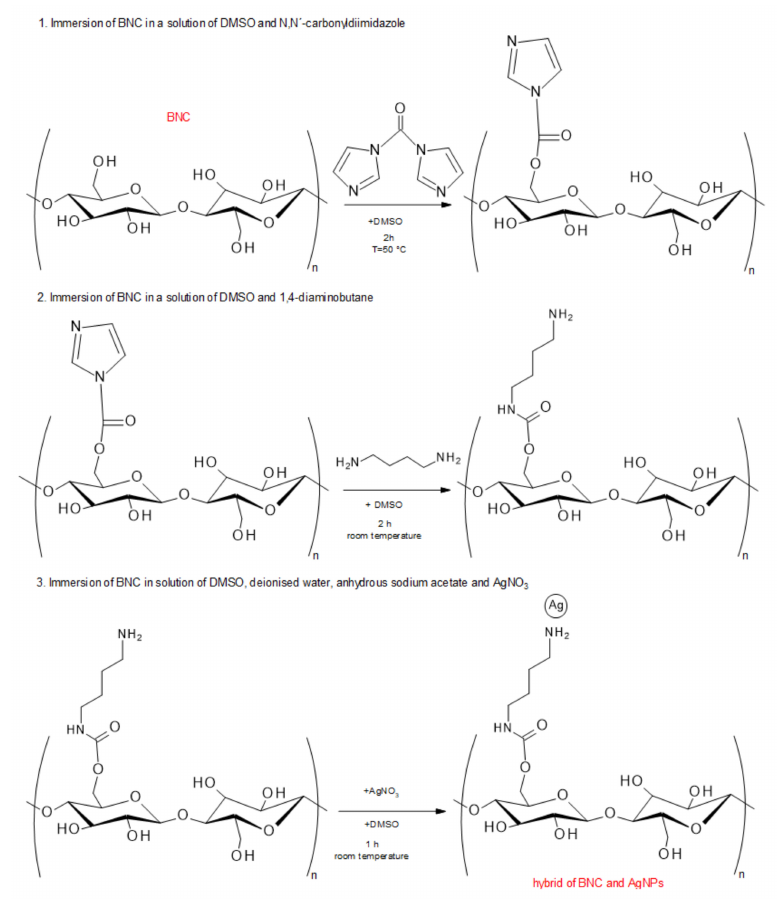
Figure 5. Schematic procedure to prepare hybrids consisting of BNC and AgNPs (summarized by